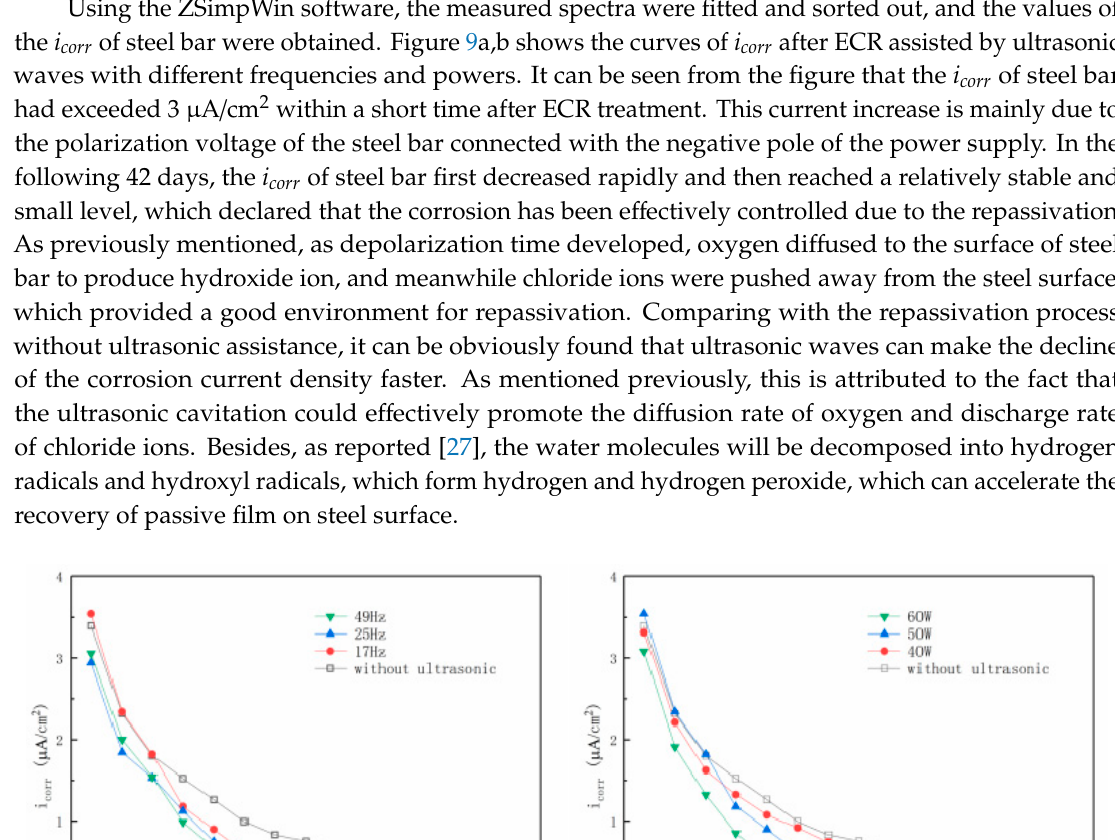
Figure 8. Typical equivalent circuit of reinforced concrete structure.